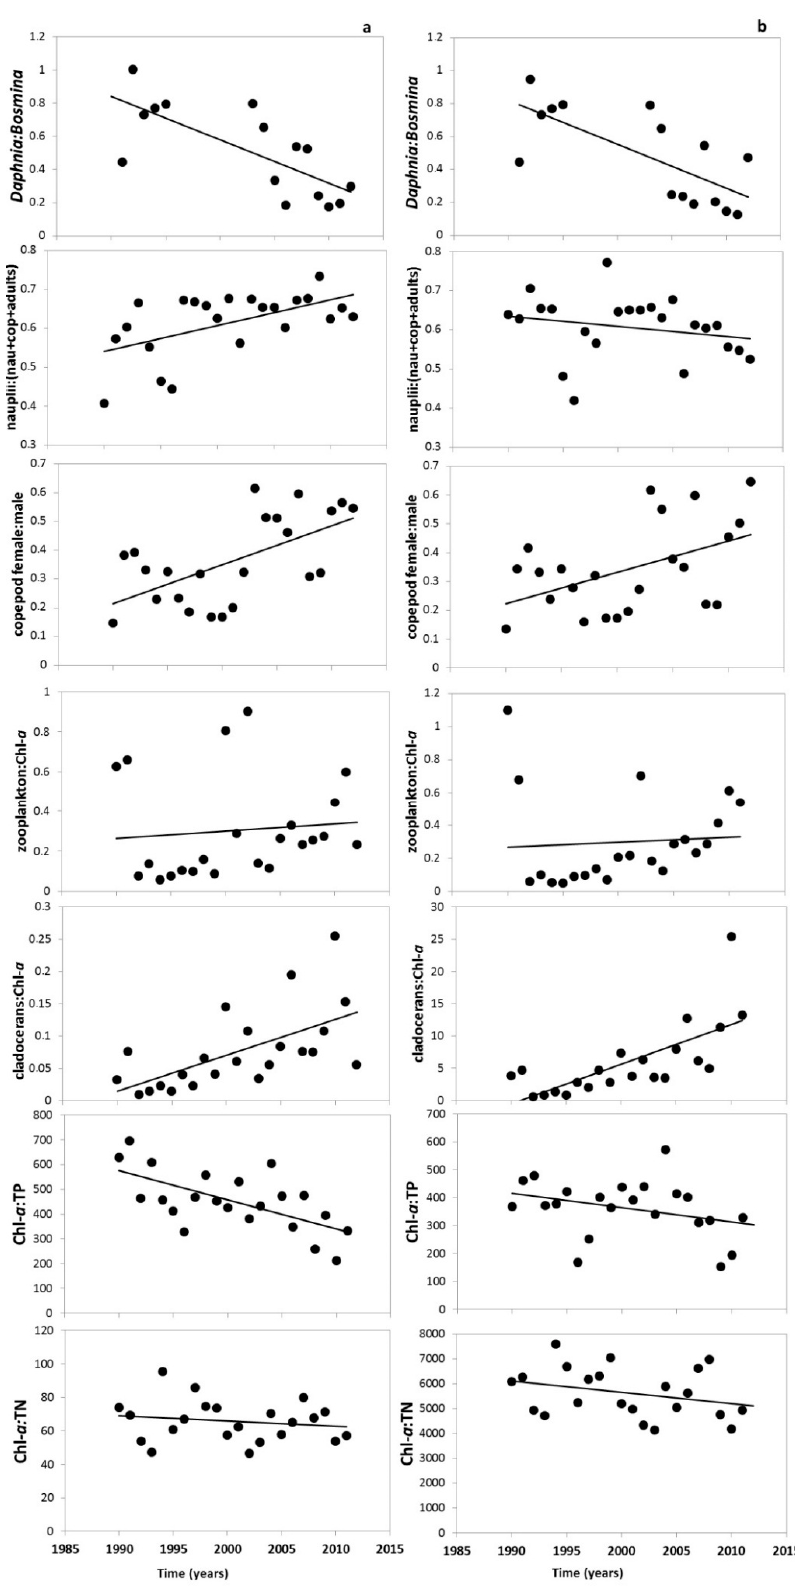
Figure 6. Interpolated mean annual ( a ) and summer ( b ) values of Daphnia:Bosmina , Copepod nauplii:(nau+cop+adults), copepod female:male, zooplankton:Chl ‐ a , cladoceran:Chl ‐ a , Chl ‐ a :TP and Chl ‐ a :TN ratios during 1990–2012 in Lake Søbygaard.